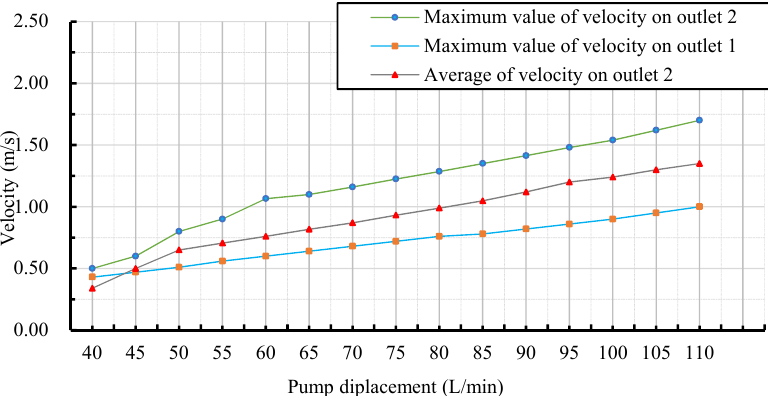
Figure 9. Effect of pump displacement on the outlet velocity of the drilling fluid.